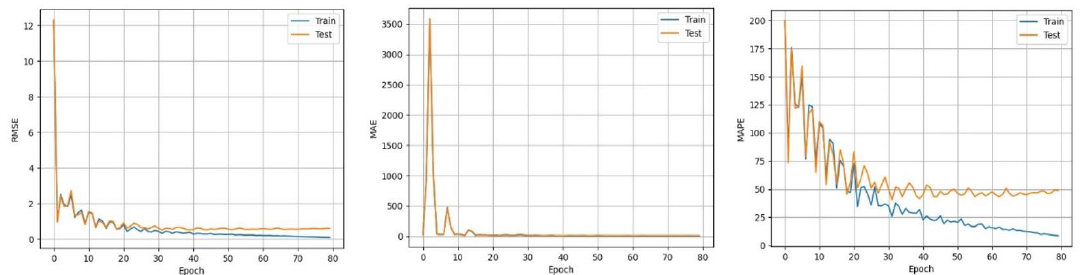
Figure 9. The change of the three indicators with respect to epochs during the training and testing process.